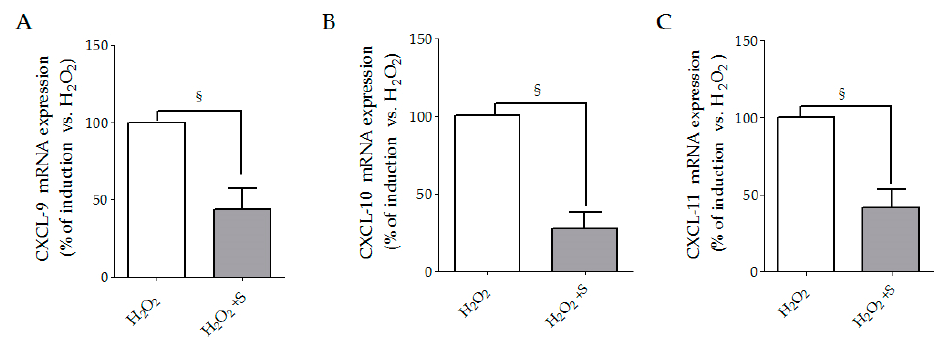
Figure 2. CXCL-9 ( A ), CXCL-10 ( B ) and CXCL-11 ( C ) mRNA of SSc fibroblasts cultures exposed to H 2 O 2 (100 µ M, 24 h) in the presence or absence of sildenafil (1 µ M). Data are shown as the fold increase vs. H 2 O 2 taken as 100% ± SEM ( n = 3). Statistical significance was determined using the Mann–Whitney t -test. § p < 0.05 of H 2 O 2 vs. H 2 O 2 + S. S , sildenafil. Experiments were repeated at least three times ( n = 3) with essentially identical results.